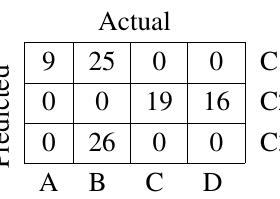
Figure 4. Confusion matrix for MFD and spectral